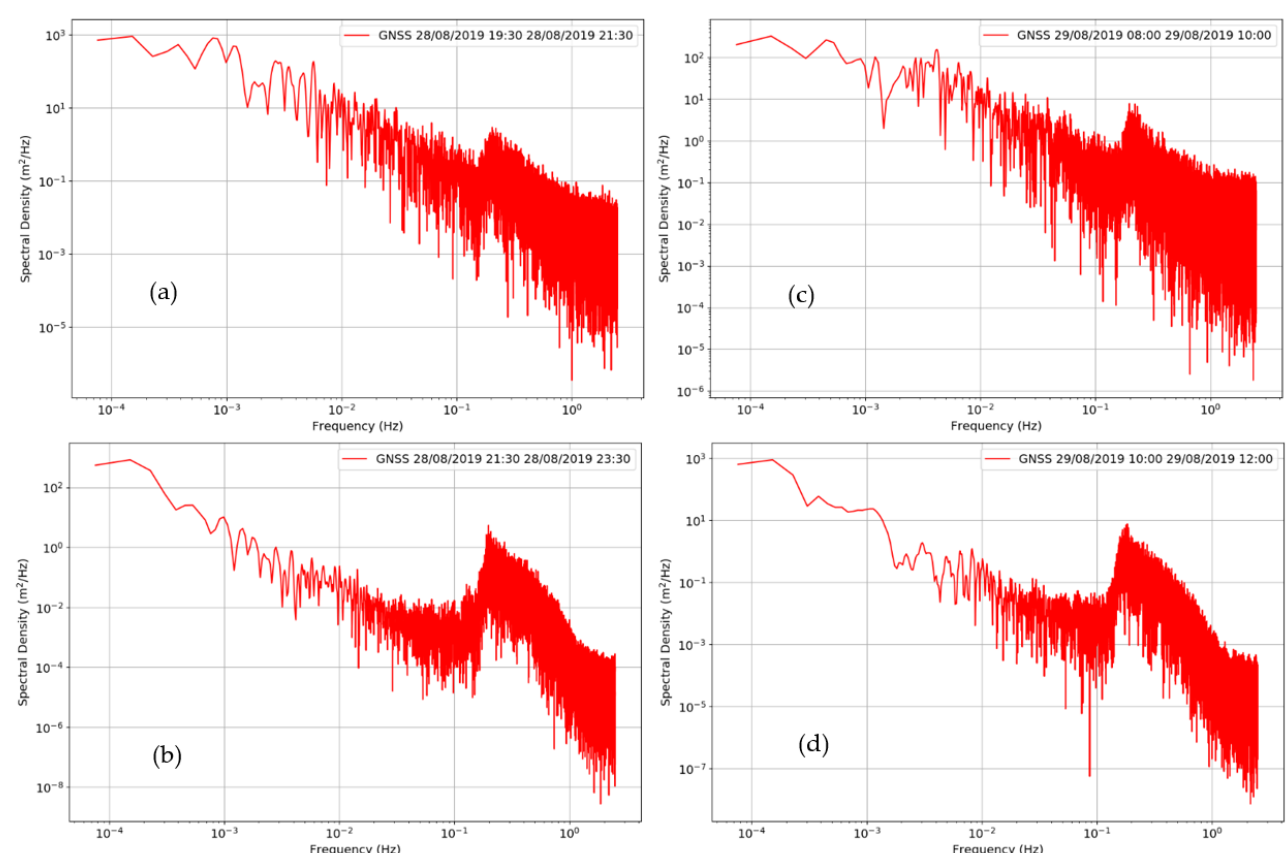
Figure 13. Spectral density for tidal cycle A—( a ) 2 hr period before HW, ( b ) 2 hr period after HW, and tidal cycle B–( c ) 2 hr period before HW, ( d ) 2 hr period after HW. Table 4. Wave parameter comparisons between the GNSS buoy and the Cleveleys wave buoy for two-hour periods either side of high water (HW).